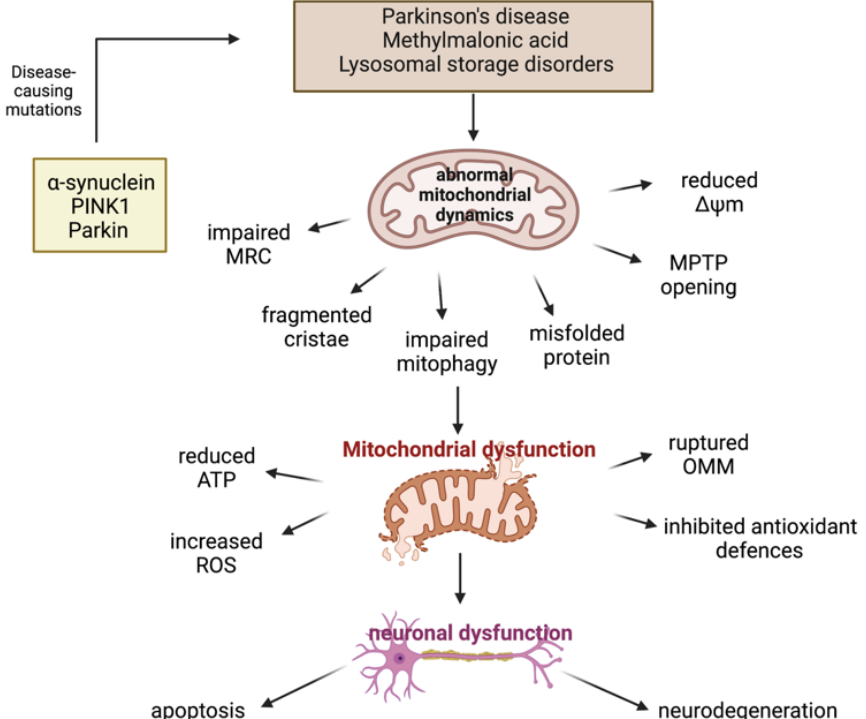
Figure 2. Putative common mechanisms leading to mitochondrial dysfunction and neurodegenera- tion in Parkinson’s disease, methylmalonic acidaemia, and lysosomal storage disorders. α -Synuclein, PINK1, and parkin are proteins frequently mutated in neurodegenerative disorders causing abnormal mitochondrial dynamics, including altered mitochondrial morphology, impaired MRC function and mitophagy, misfolded proteins, and reduced ∆Ψ m. These consequences result in mitochondrial dysfunction, triggering neuronal dysfunction that leads to neurodegeneration and neuronal death (created using biorender.com). PINK1—TEN-induced kinase 1; MRC—mitochondrial respiratory chain; MPTP— mitochondrial permeability transition pore; ∆Ψ m—mitochondrial membrane potential; ATP—adenosine triphosphate; ROS—reactive oxygen species; OMM—outer mitochondrial